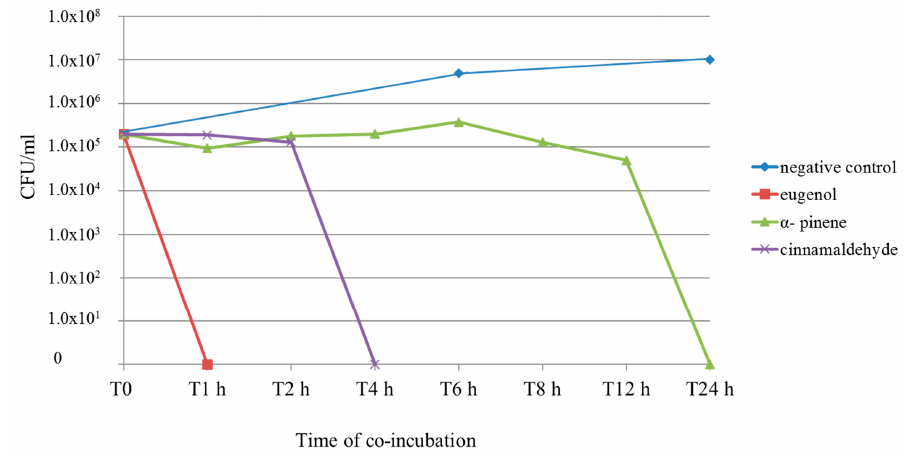
Figure 2. Time–kill curve for C. albicans strain number 15. Compounds were tested at their MFCs (2 × MIC in this case). MIC: minimal inhibitory concentration. MFC: minimal fungicidal concentration. CFU: colony-forming unit. Time is expressed in hours. Negative control: no compounds were added to the cell suspension.